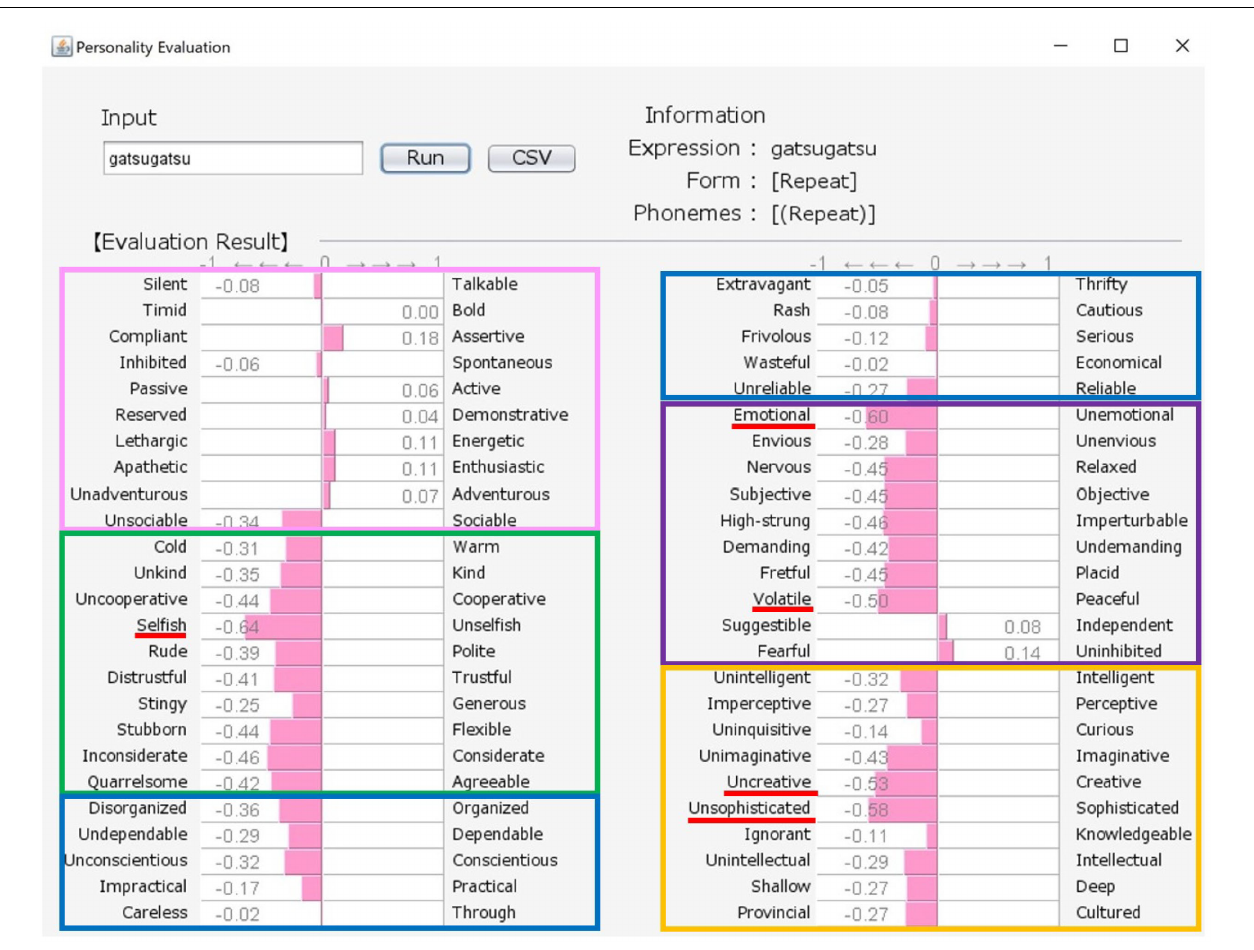
FIGURE 2 | Output for “gatsu-gatsu (greedy)” personality (aggressive and unpleasantly positive). The pink, green, blue, purple, and orange frames indicate Extroversion, Agreeableness, Conscientiousness, Neuroticism, and Openness, respectively.